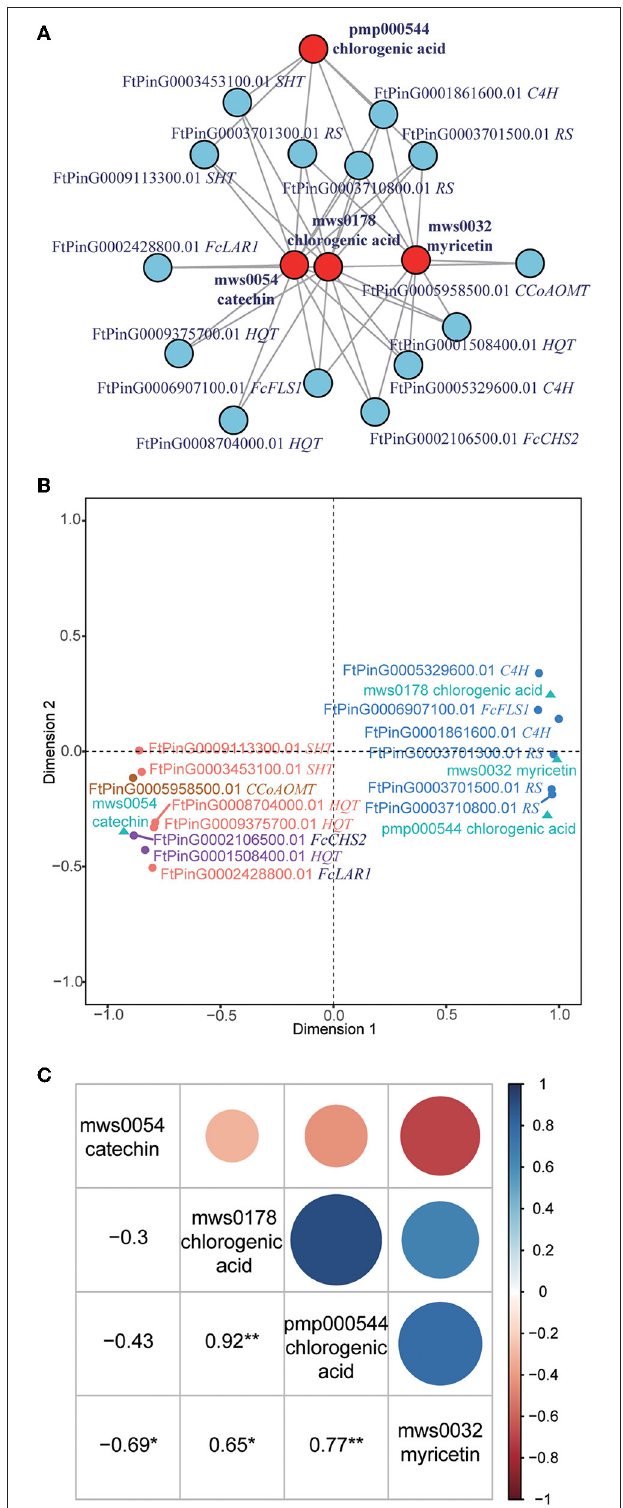
FIGURE 3 | Integration of the transcriptome and metabolome profiles. (A) Interaction network of metabolites and genes related to catechin. The metabolites are presented as red circles, and the genes are presented as blue